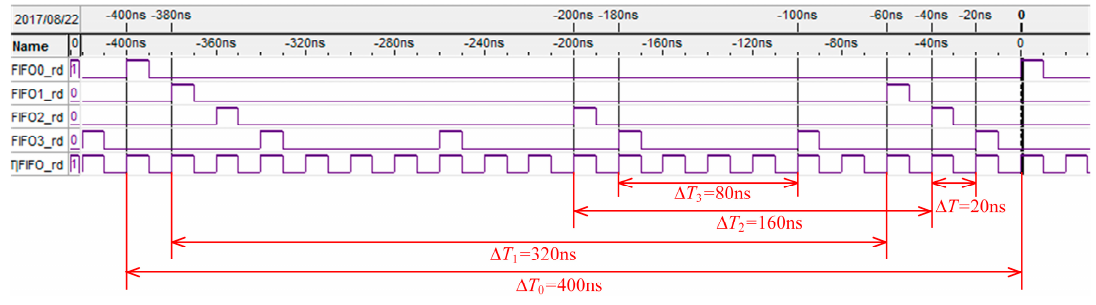
Figure 6. The 4 FIFOs reading timing waves of the ETSPS algorithm from Signaltap.